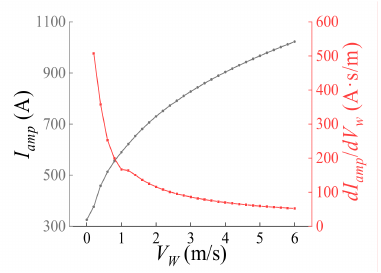
Figure 3. Ampacity due to the variation of wind speeds.